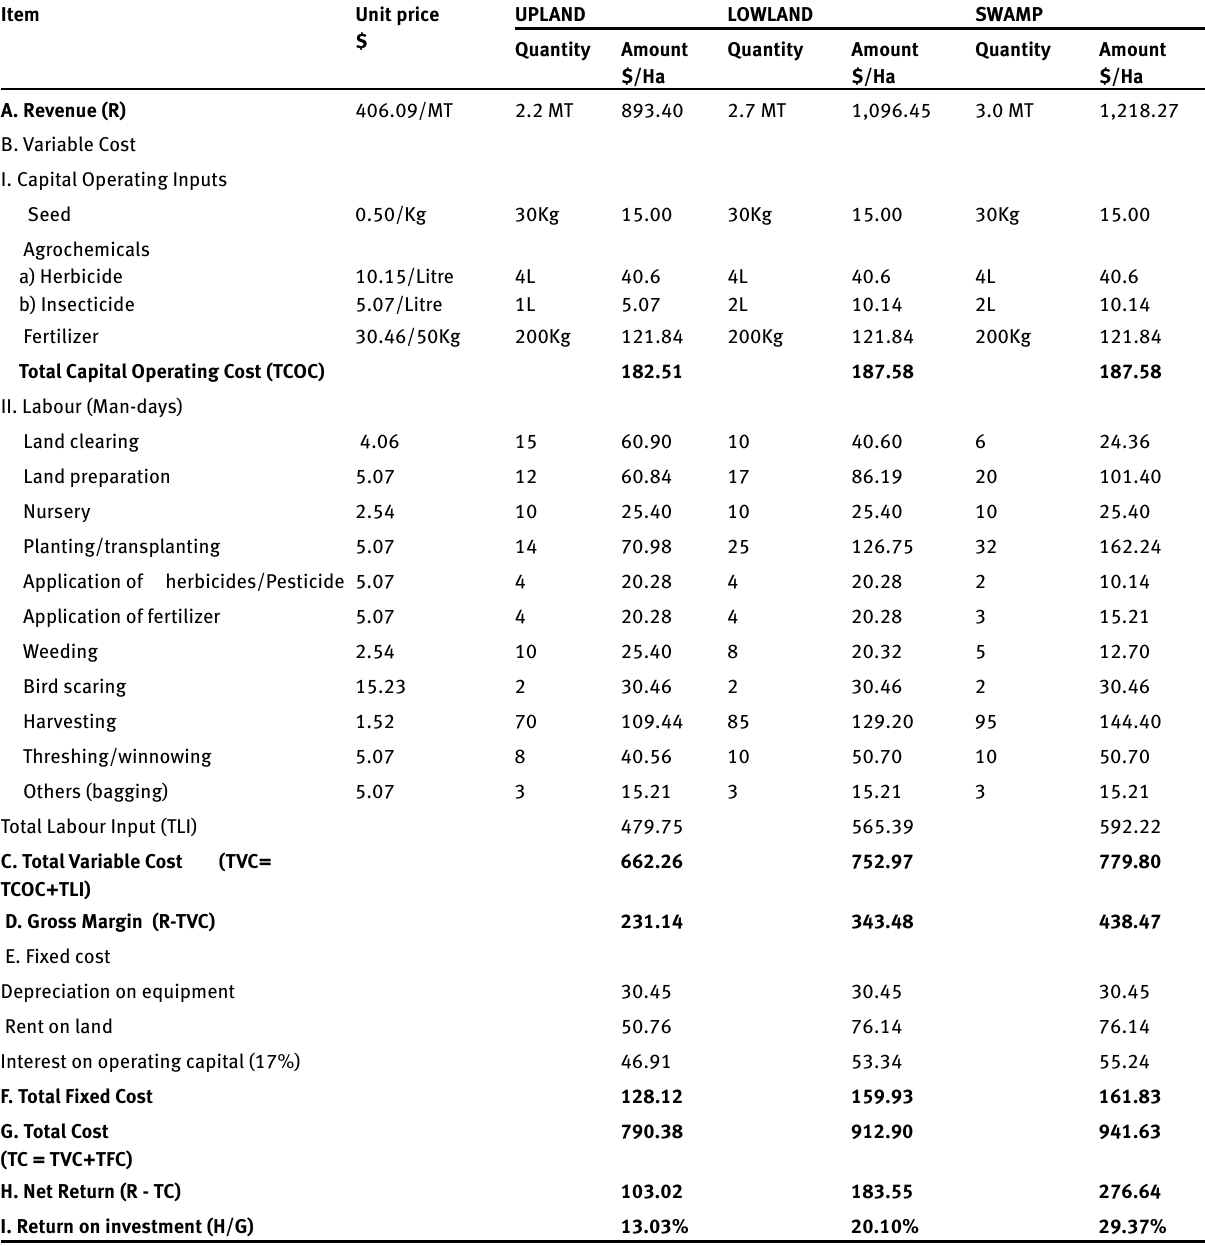
Table 5: Profitability (per cycle) of 1ha of rice production in Ebonyi